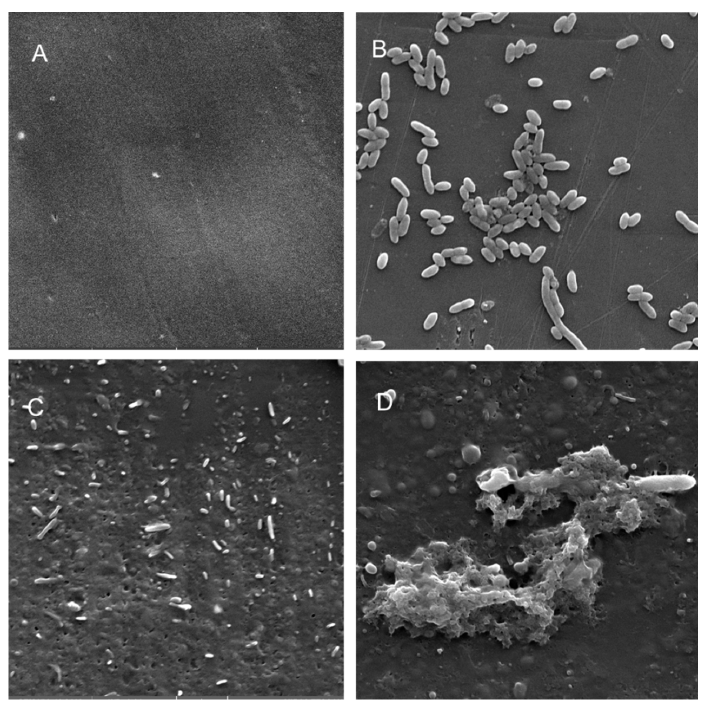
Figure 6. Scanning electron micrographs ( A ) of un ‐ colonized PP (×10,000); ( B – D ) of A. hydrophila in the planktonic phase ( B ; ×6540), adherent phase on PP ( C ; ×7530) and biofilm phase induced on PP pressed on blood agar ( D ; ×2540).